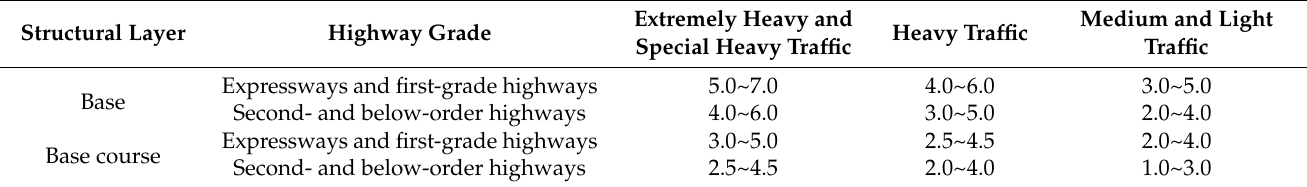
Table 7. Unconfined compressive strength standard of cement-stabilized material at 7 days (MPa). Structural